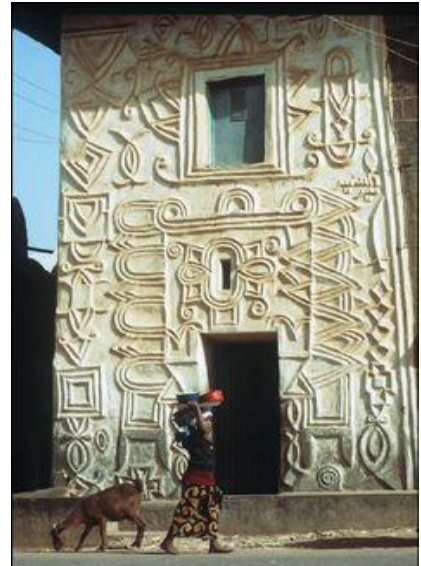
Figure 8. Relief Design on a Street Facing Façade